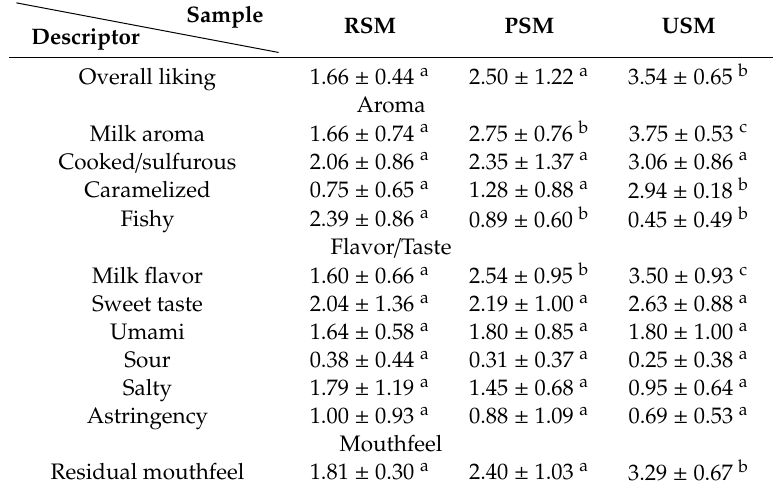
Table 1. Sensory evaluation results of three di ff erent kinds of skim milk